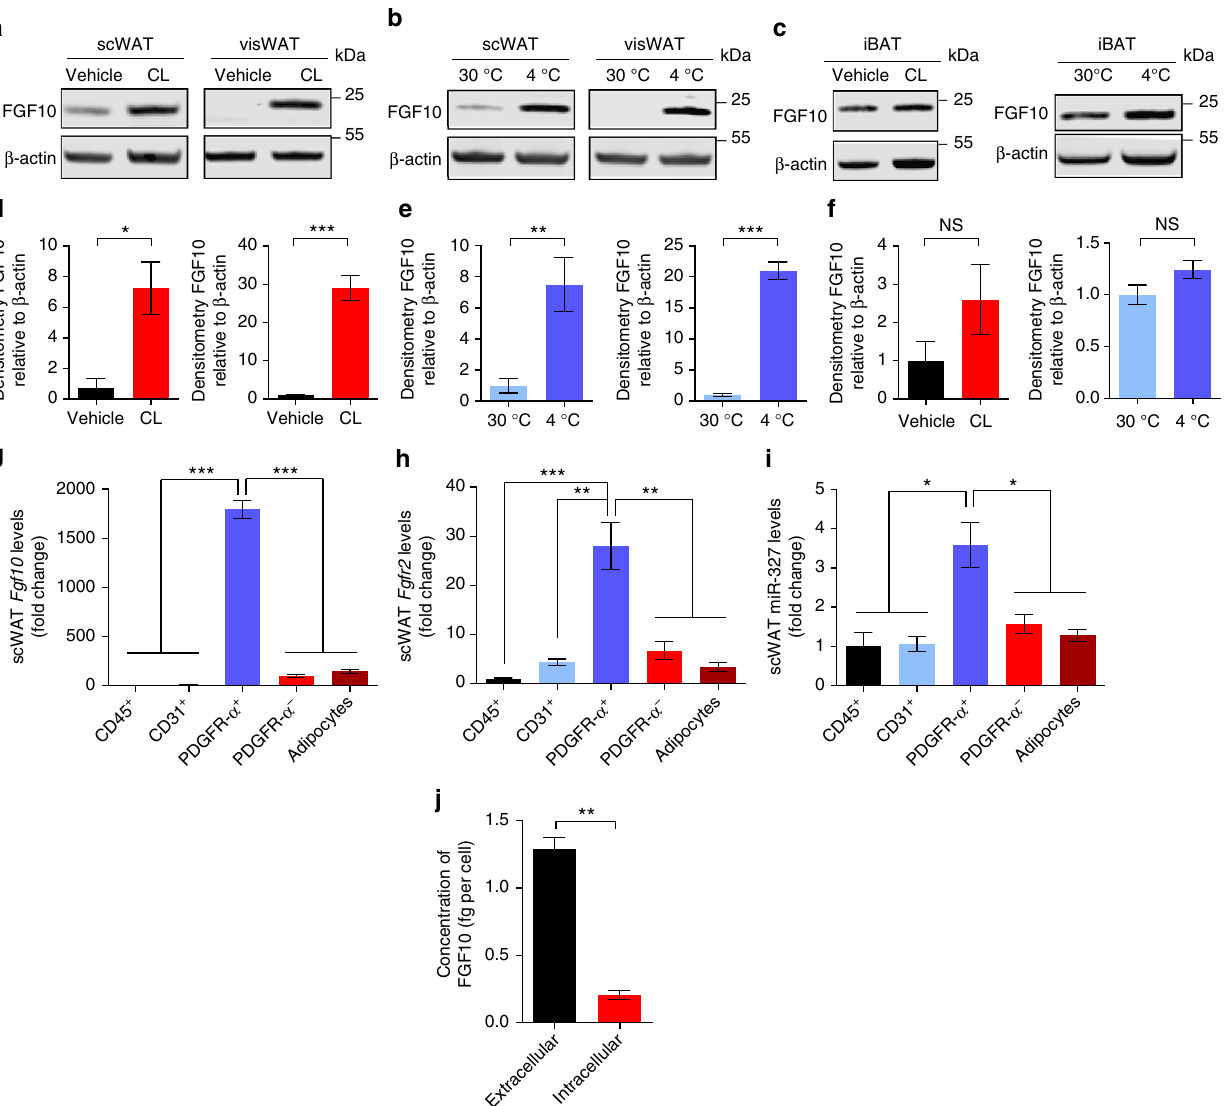
Fig. 3 FGF10 protein is upregulated upon browning and secreted by preadipocytes. a – f Western immunoblot analysis of FGF10 in 3-day CL-316243- or 1- week 4 °C-treated scWAT, visWAT, and iBAT compared to their respective controls. FGF10 protein levels were quanti fi ed as densitometric signals and normalized to β -actin ( n = 5 samples per group). g – i qPCR analysis of Fgf10, Fgfr2 , and miR-327 mRNA levels in different cellular fractions of scWAT ( n = 5 samples per group). j ELISA analysis of FGF10 protein levels in primary preadipocytes isolated from scWAT ( n = 5 samples per group). kDa, kilodalton. NS, not signi fi cant. * P < 0.05, ** P < 0.01, and *** P < 0.001 by Student ’ s t -test. Data presented as mean ± the miR-327 mimic-transfected 3T3-L1 preadipocytes (Fig. 4g, h, impact of miR-327 on adipocyte differentiation, 3T3-L1 pre- adipocytes were induced for differentiation 33 – 35 . Surprisingly, transfection of 3T3-L1 preadipocytes with a miR-327 mimic, but not with miR negative control (miR-NC), largely blocked adi- pocyte differentiation as shown by deposition of Oil Red O + lipid droplets (Fig. 5a). Quanti fi cation analysis showed an ~90% inhibition of preadipocyte differentiation in the miR-327 transfected 3T3-L1 preadipocytes relative to miR-NC trans- fected cells (Fig. 5c). In a gain-of-function experimental setting, we modi fi ed the differentiation protocol by lowering insulin levels. With the modi fi ed protocol only ~35% of preadipocytes differentiated to adipocytes (Fig. 5b, d). Under such conditions, transfection of 3T3-L1 preadipocytes with a miR-327 inhibitor signi fi cantly increased the number of differentiated adipocytes (Fig. 5b, d). To relate our fi ndings to physiological relevance, we further isolated primary preadipocytes using a standard protocol 35 .